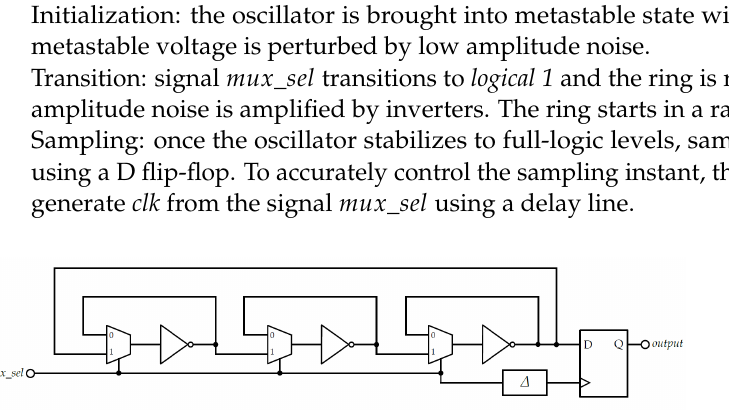
Figure 2. Metastable Ring